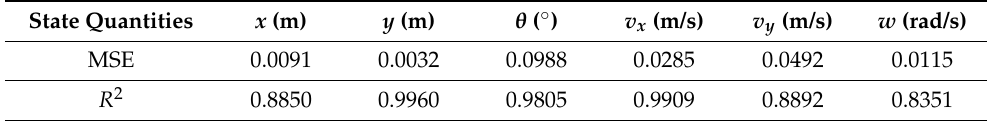
Table 4. Results of prediction accuracy of scaled test